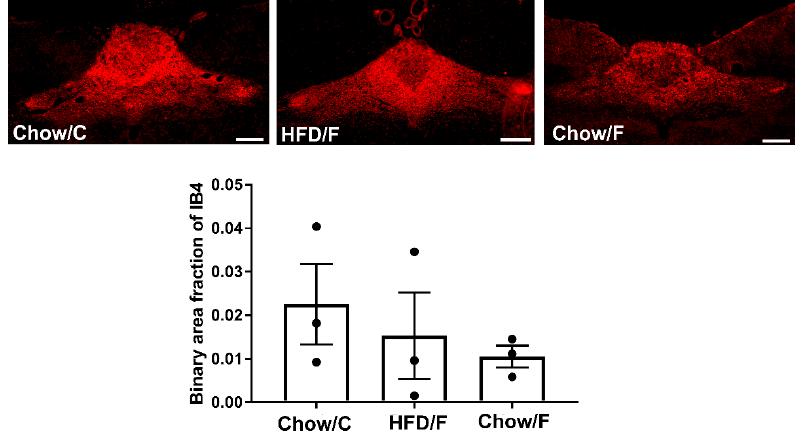
Figure 6. Manipulating the gut microbiome through a cecal fistula did not affect the density of vagal afferents in the intermediate NTS. Representative sections of intermediate NTS of animals fed a high-fat diet for seven weeks (HFD/F, n = 3) and rats fed regular chow (Chow/C and Chow/F, n = 3 respectively) are shown. Binary analysis of the area fraction of IB4-labelled vagal afferents revealed no significant differences in the density of labelled afferent terminals between the three cohorts. Graphs represent mean + SEM. Scale bar = 200 μ m.